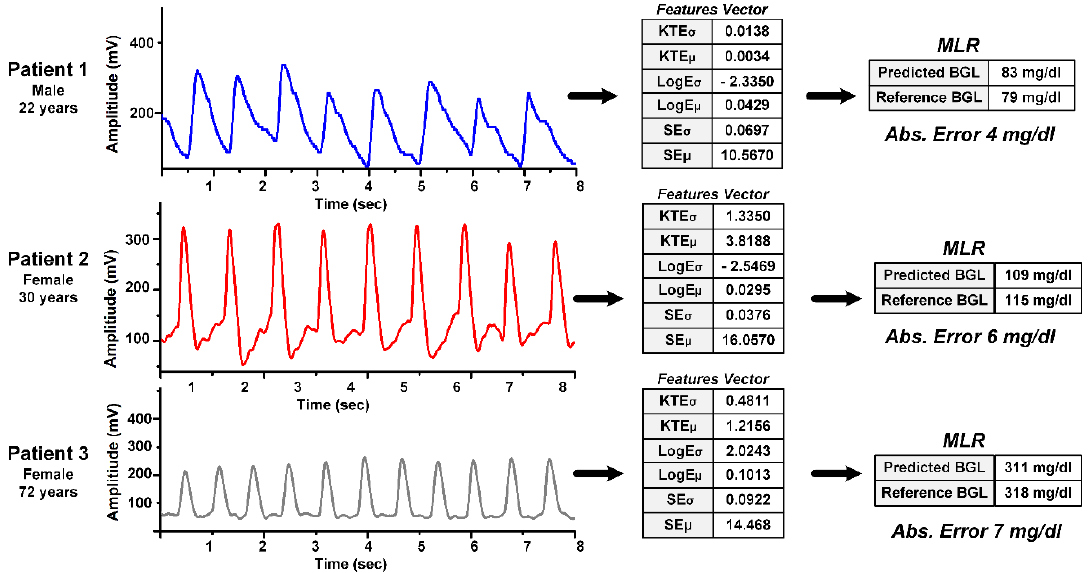
Figure 8. Measured PPG signals with BGL estimation for 3 different subjects having reference a BGL of 79, 115, and 318 mg/dL, respectively. Reprinted with permission from [44].